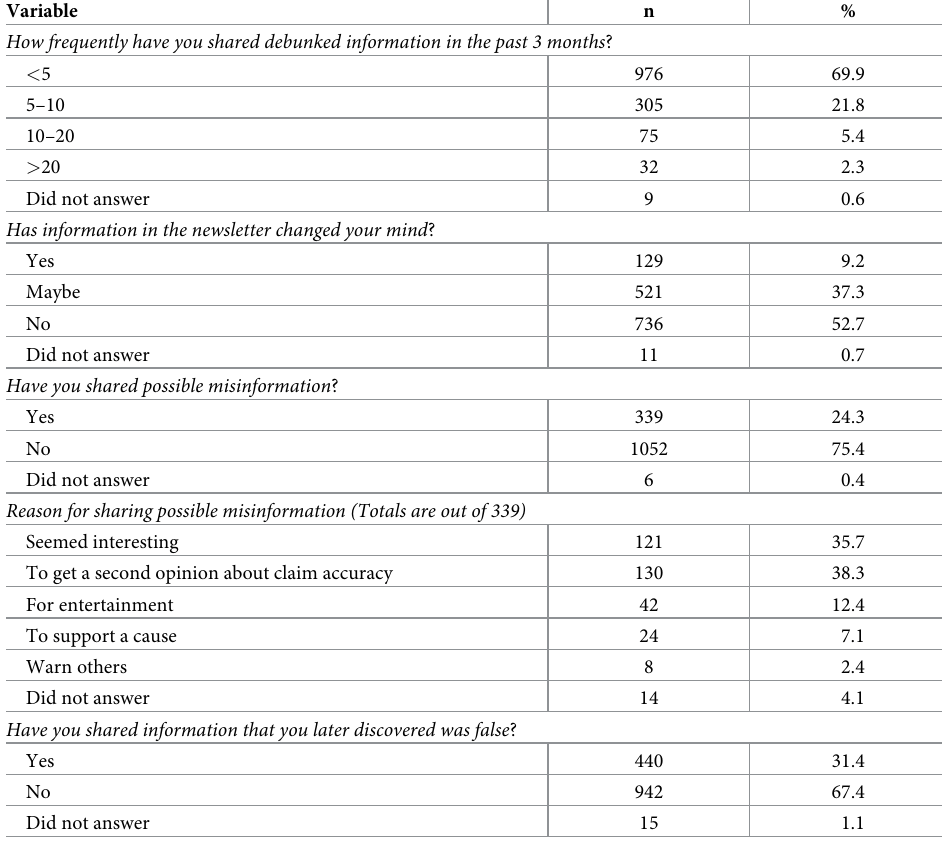
Table 3. Frequency data for dichotomous study